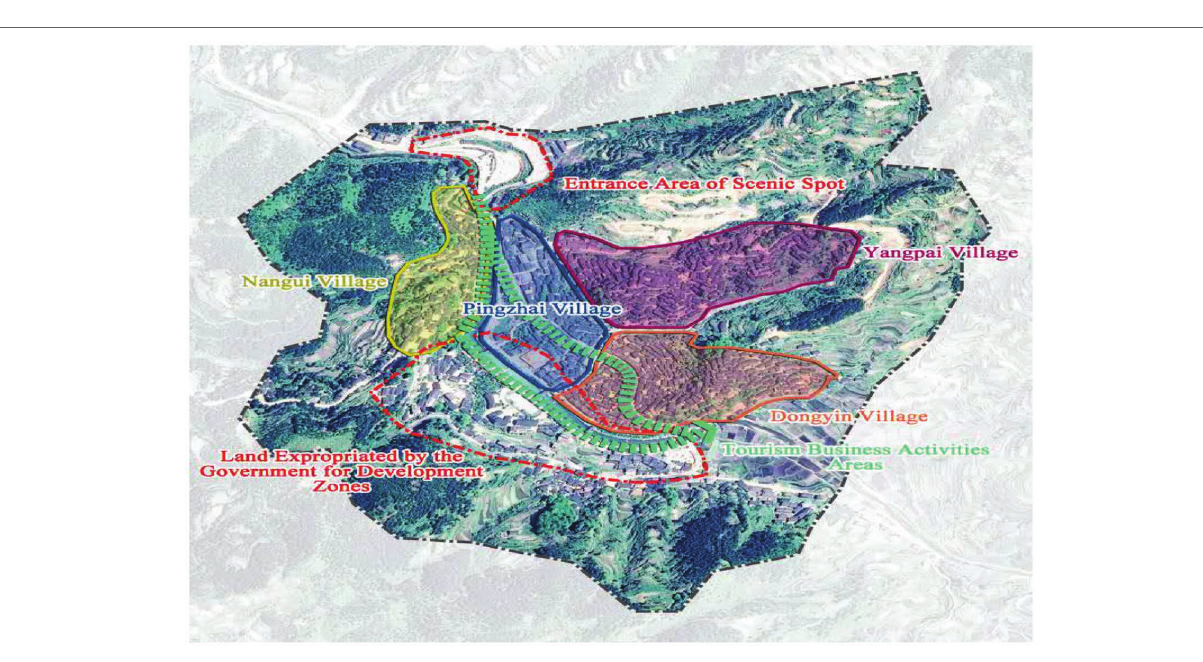
FIGURE 3 | Village layout topography (drawn based on Google